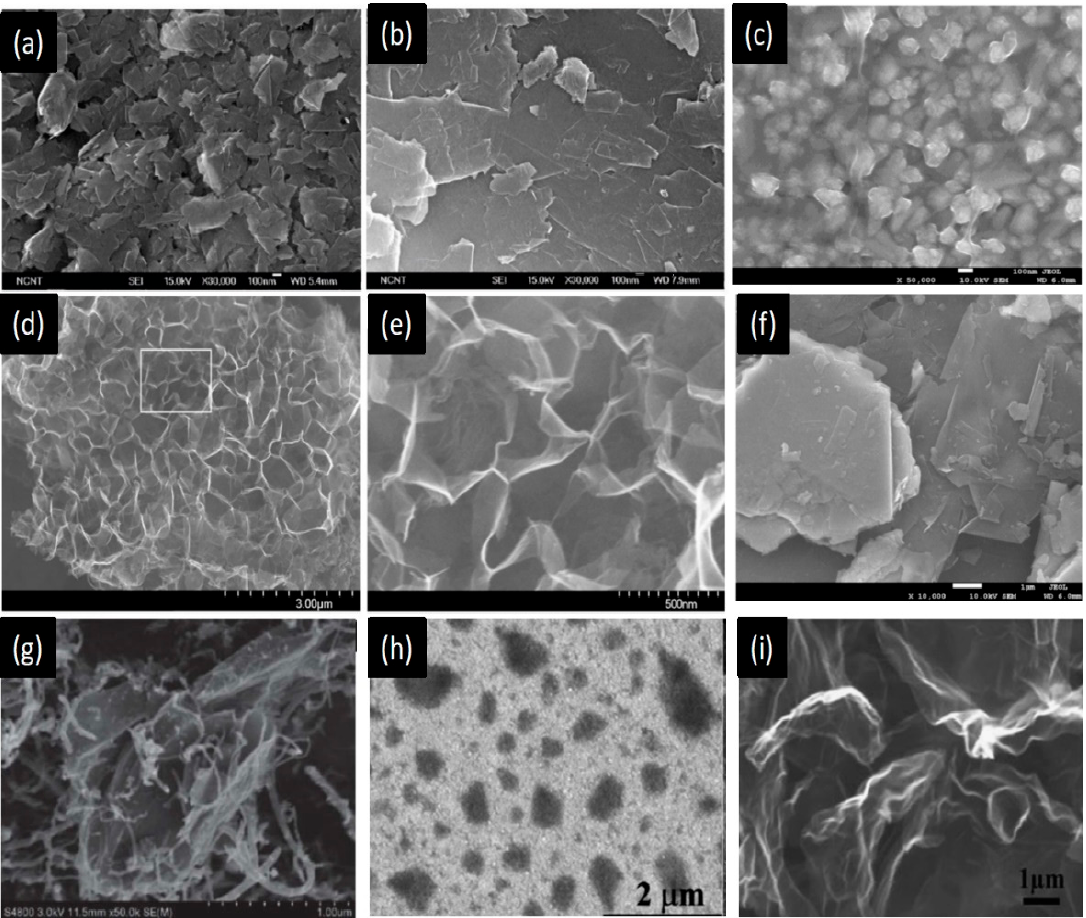
Figure 18. SEM images of ( a ) sub-micrometer- and ( b ) micrometer-scale graphite. Reprinted with permission from Reference [53]. FE-SEM surface images of ( c ) graphene / Pt hybrid. Reprinted with permission